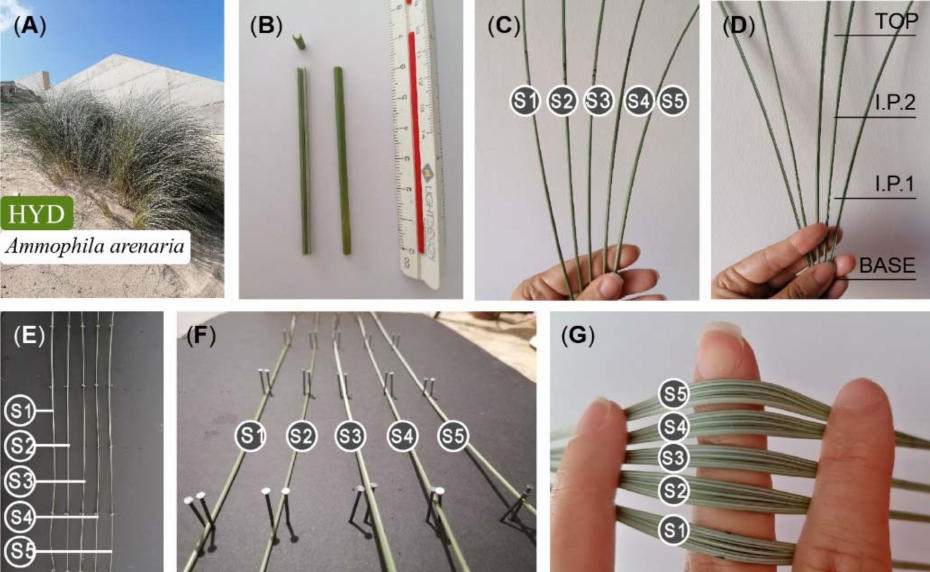
Figure 6. ( A ) Photographic register of Ammophila arenaria ; ( B ) reference of leaf dimensions of marram grass; ( C ) adaxial face of the leaf samples; ( D ) abaxial face with identification of the four measurement points; ( E , F ) positioning of the samples in a platform that allows flexible setting; ( G ) adaxial face. Source: